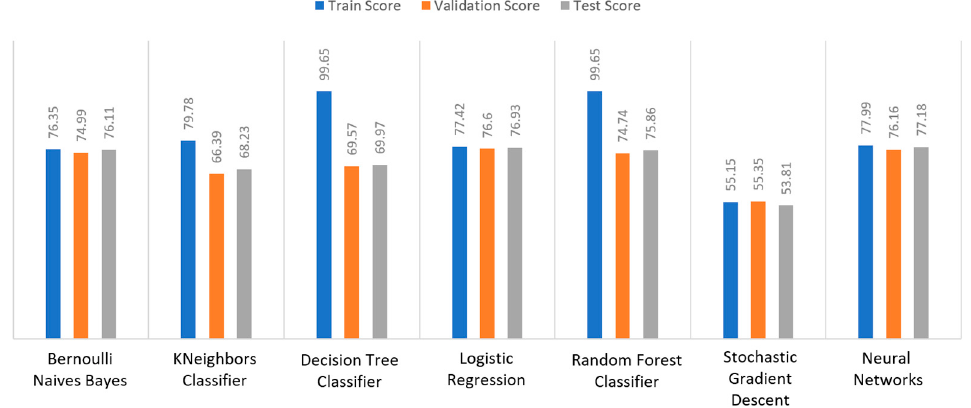
Figure 15. Train–validation–test score for diabetes use case.